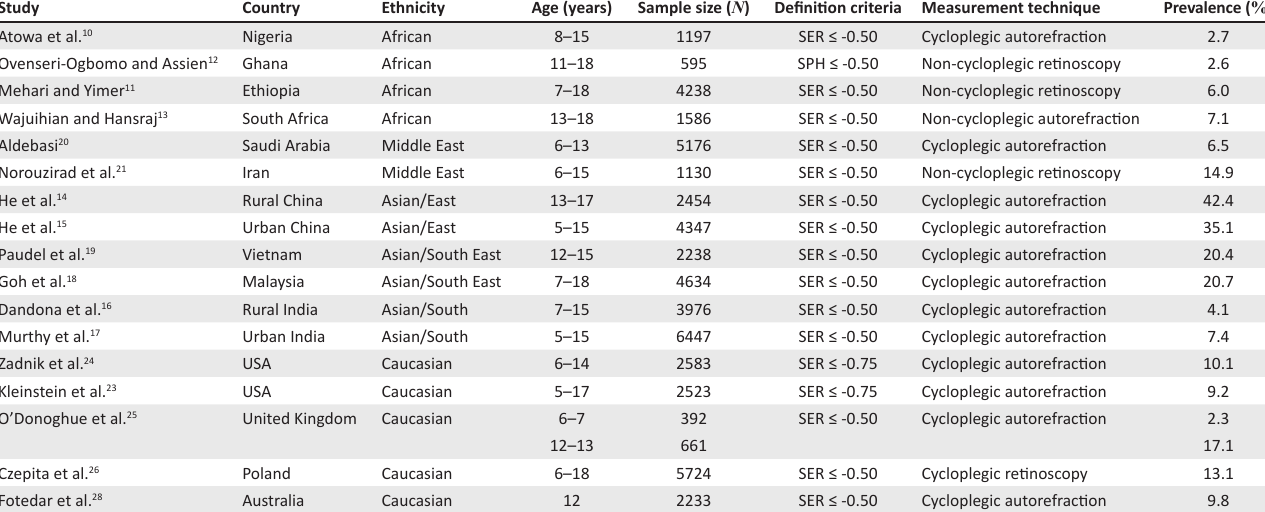
TABLE 2: Prevalence of myopia among school-age children in selected countries from various geographic regions. Study Sample size ( N ) Definition criteria Measurement technique